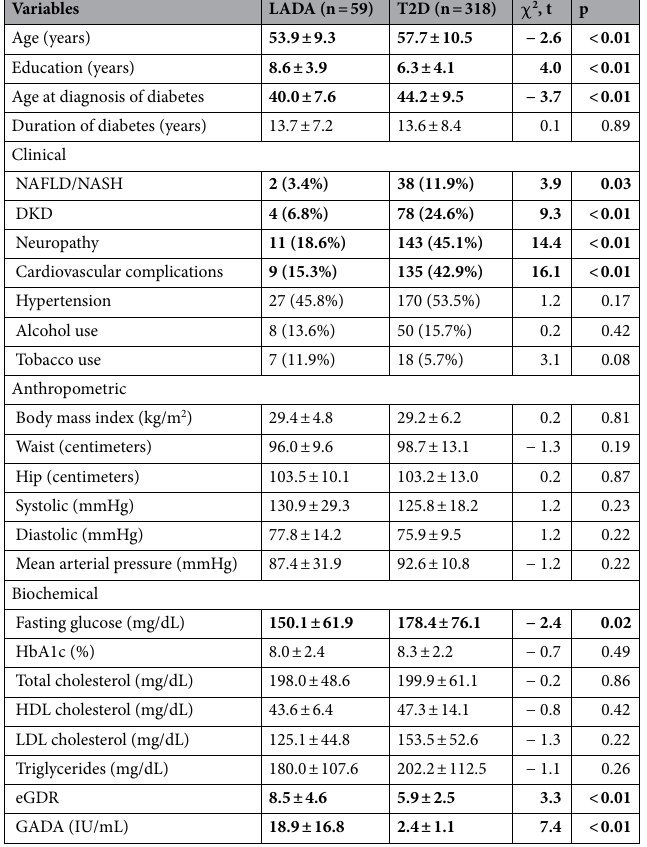
Table 1. Demographic, clinical, anthropometric, biochemical characteristics of patients with LADA and T2D. Significant values are in [bold]. LADA, Latent autoimmune diabetes in adults; T2D, Type 2 diabetes; NAFLD, Nonalcoholic fatty liver disease; NASH, Nonalcoholic steatohepatitis; DKD, Diabetic kidney disease, eGDR, Estimated glucose disposal rate; GADA, Glutamic acid decarboxylase antibodies. We used the Chi-squared test for categorical variables, and the t-Student test for numerical data. A p-value < 0.05 was considered significant.